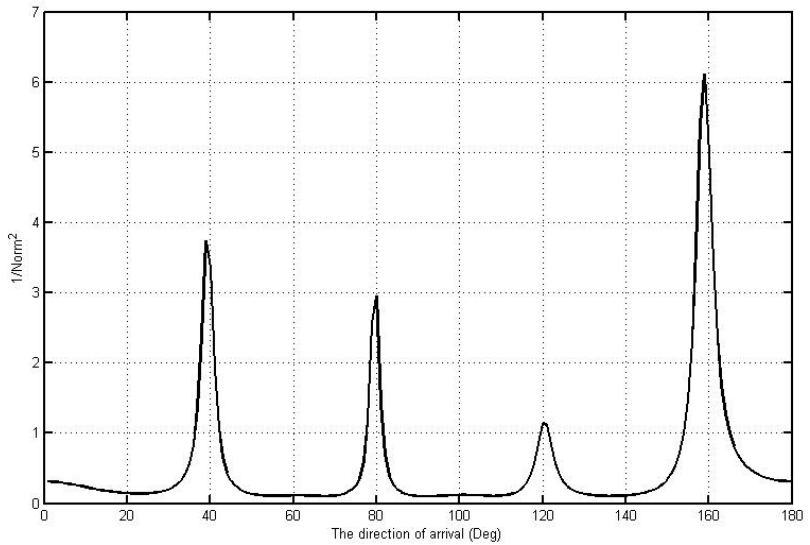
Figure 19. The spectrum of each signal arrival angle.